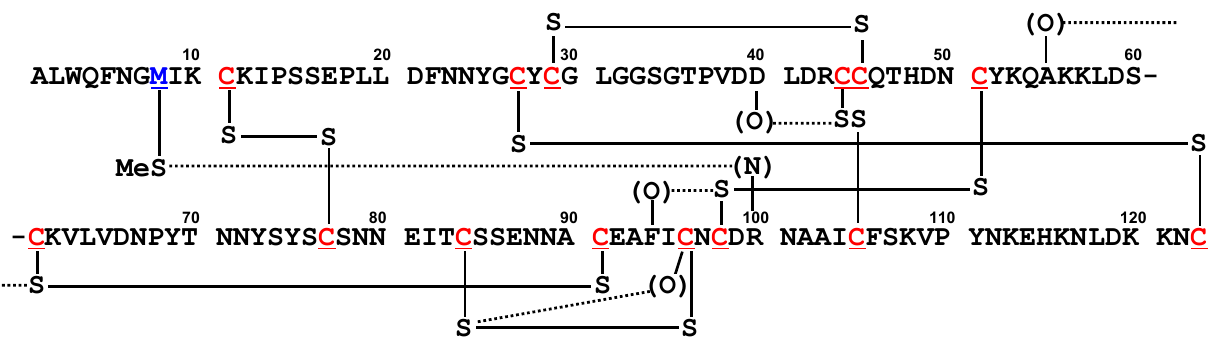
with notations of common S···X 2